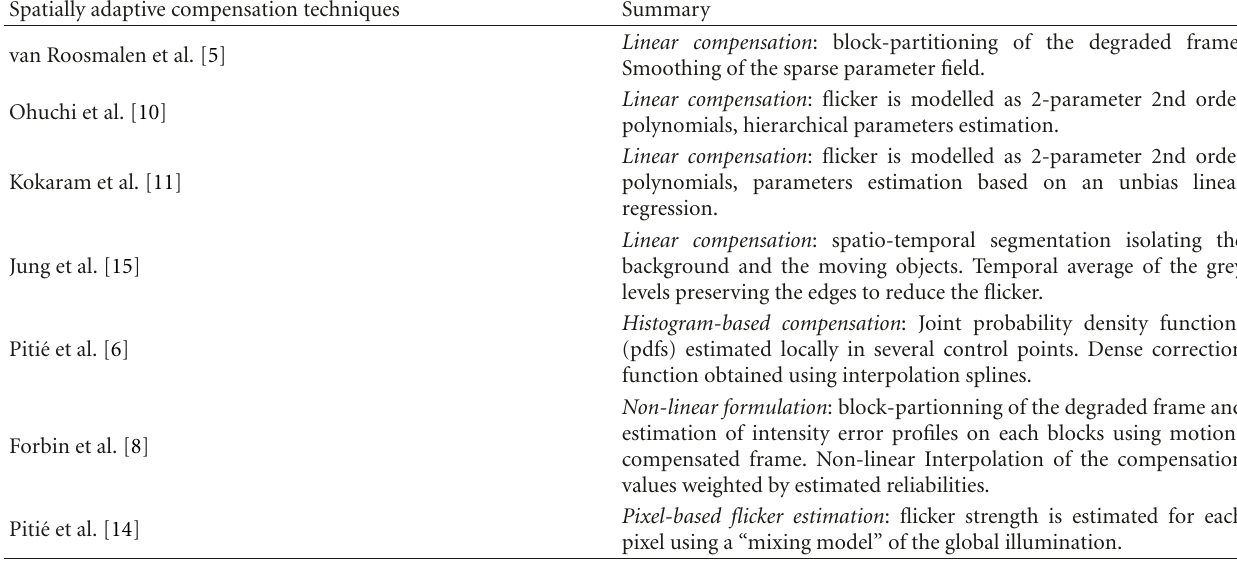
Table 2: An overview of the spatially adaptive compensation